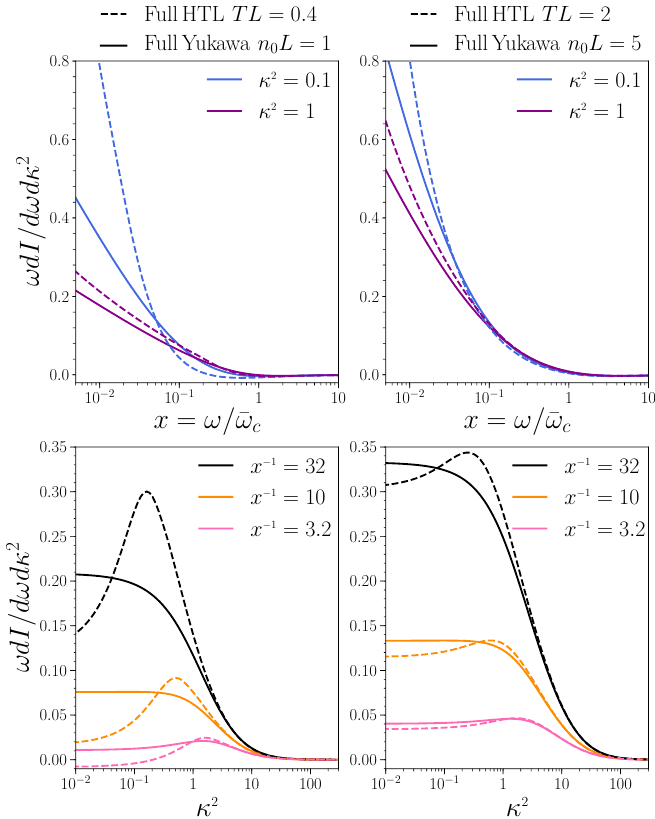
Figure 8 . Left column: full medium-induced k ? -di(cid:11)erential gluon radiation spectrum for the Yukawa-type interaction with n 0 L = 1 (solid lines) and the HTL interaction with TL = 0 : 4 (dashed lines) as a function of x = != (cid:22) ! c = 2 !=(cid:22) 2 L for di(cid:11)erent values of (cid:20) = k=(cid:22) (top) and versus (cid:20) 2 for di(cid:11)erent values of x (bottom). Right column: same as left panel for the Yukawa collision rate with n 0 L = 5 (solid lines) and for the HTL collision rate with TL = 2 (dashed